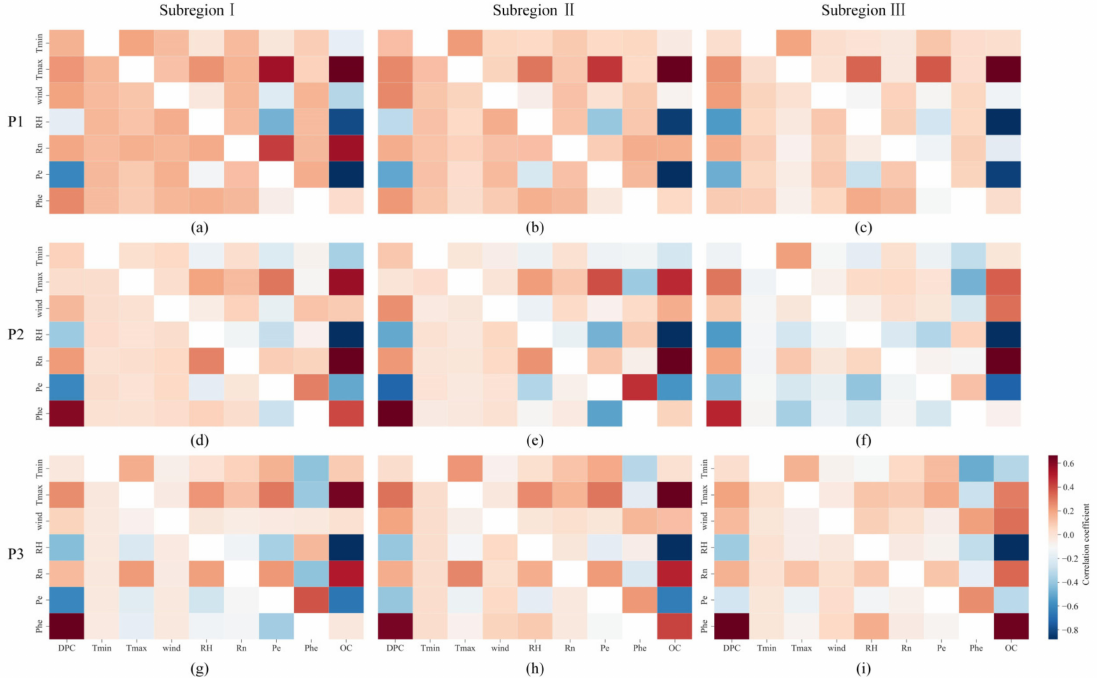
Figure 6. Interannual variation in each factor on the path analysis chart for the irrigation water requirement of winter wheat in P1 ( a – c ), P2 ( d – f ) and P3 ( g – i ) stages in subregions I ( a , d , g ), II ( b , e , h ) and III ( c , f , i ) (DPC represents the direct path coefficients, OC represents the overall correlation coefficients and the rest are indirect path